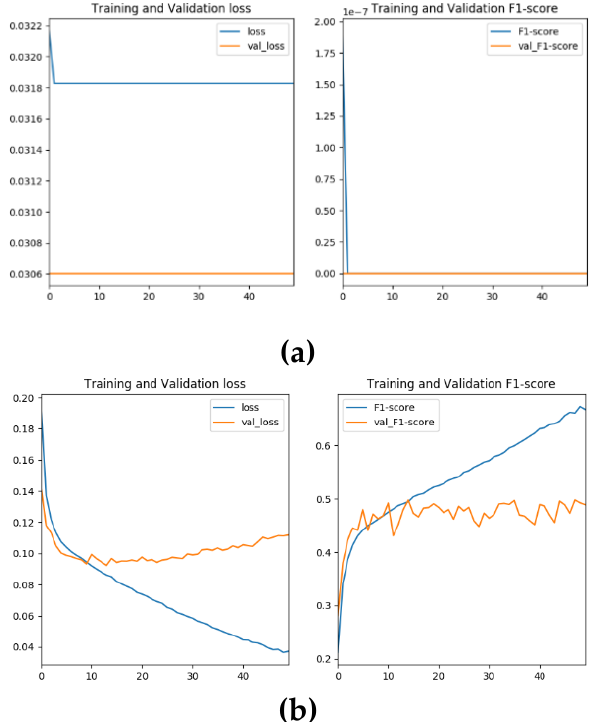
Figure 11. Transitions of loss and accuracy (F1 score) for different loss function weights: ( a ) k = 1.0 (same weight for roads and non-roads) and ( b ) k = 10.0 (10 times weight against roads).